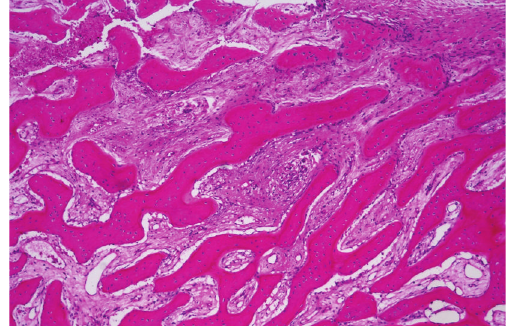
Figure 9: Ossifying fibroma, juvenile psammomatoid variant. Irregular ossicles lie in fibrous stroma. At the right side, an expanded cortical bone layer is